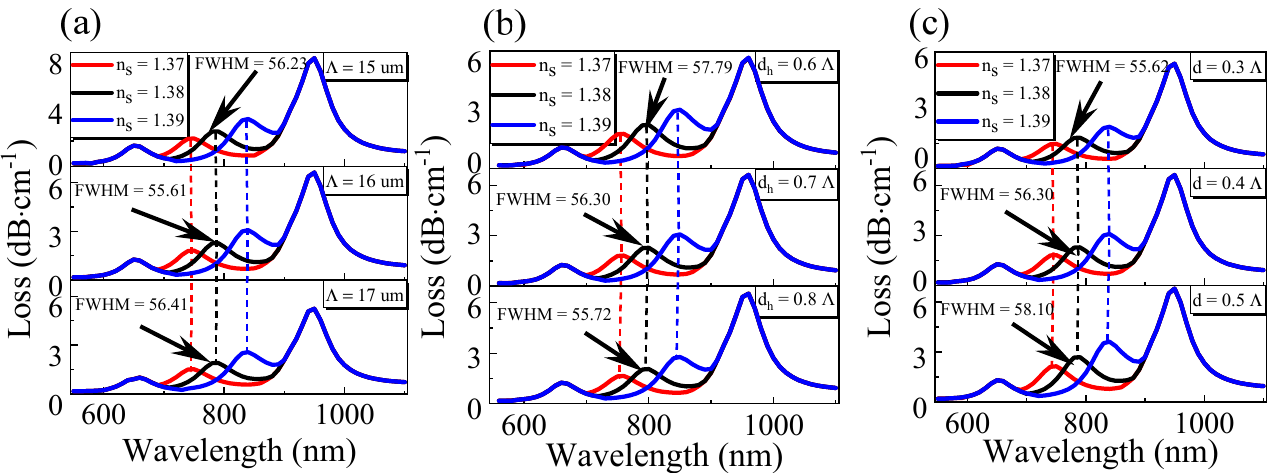
Figure 2. The variation of transmission loss with a wavelength and different refractive index of liquid to be measured: ( a ) with different air hole spacing Λ ; ( b ) with various side’s depth d h ; ( c ) with different air hole diameters d .